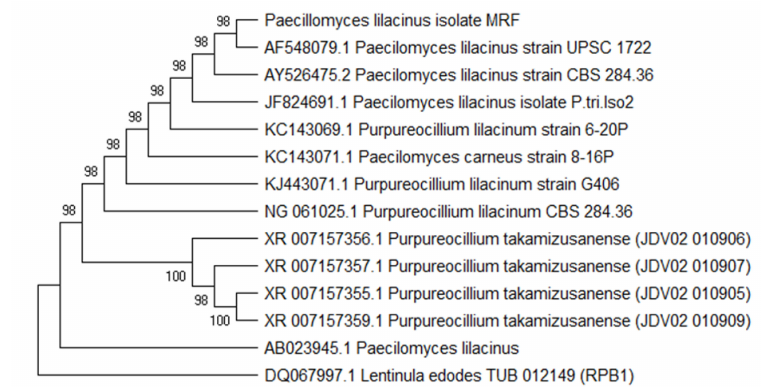
Figure 2. Phylogenetic tree of P. lilacinus (MRF). The evolutionary history was inferred using the Maximum Parsimony method. Tree #1 out of 10 of most parsimonious trees (length = 576) is shown. The consistency index is 1.000000, the retention index is 1.000000, and the composite index is 1.000000 for all sites and parsimony-informative sites (in parentheses). The percentage of replicate trees in which the associated taxa clustered together in the bootstrap test (100 replicates) are shown next to the branches. The MRF tree was obtained using the Subtree–Pruning–Regrafting (SPR) algorithm with search level 1, in which the initial trees were obtained by the random addition of sequences (10 replicates). This analysis involved 14 nucleotide sequences. There were a total of 1065 positions in the final dataset. Evolutionary analyses were conducted in MEGA X.